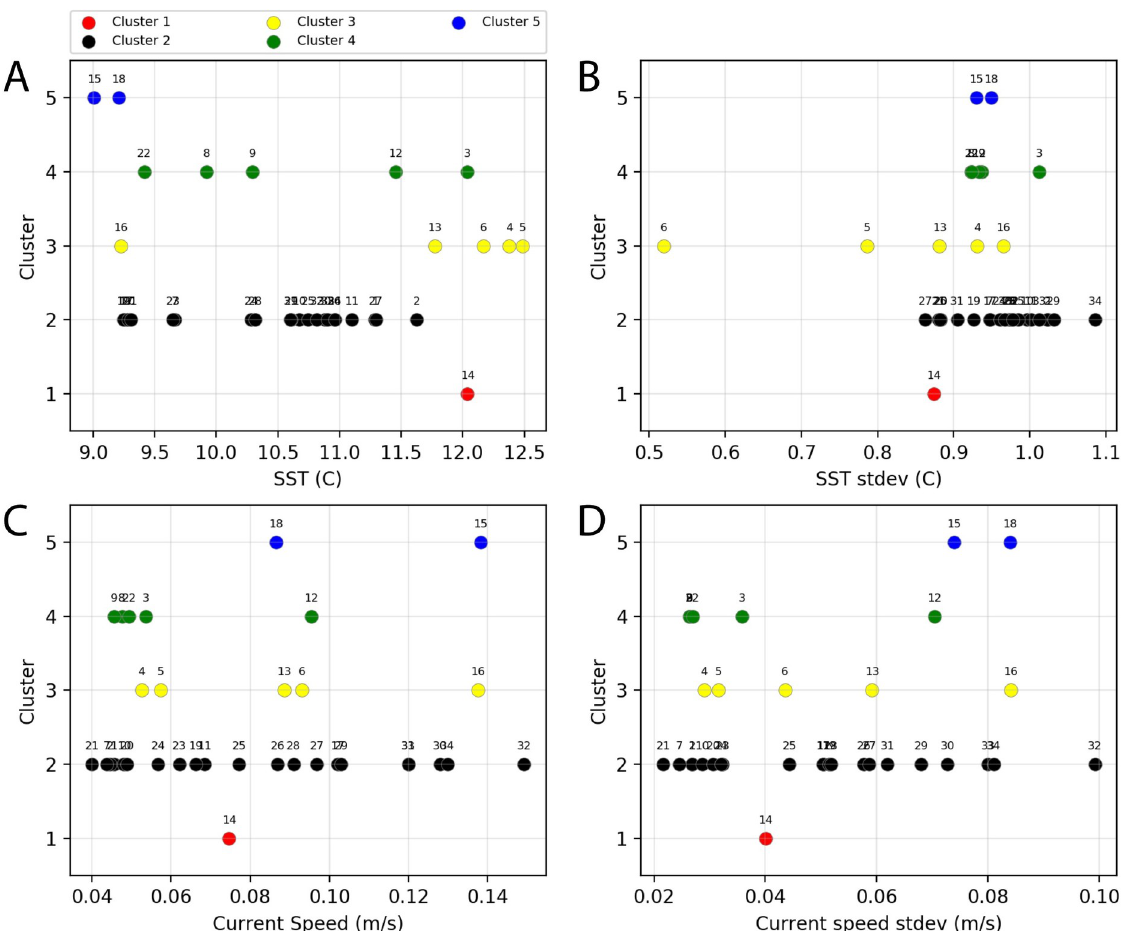
Fig 6. Relationship between community clusters and environmental variables. Distribution of (A) mean SST; (B) mean SST standard deviation; (C) mean current speed; (D) mean current speed standard deviation. All climatological means were produced for the period May 16-August 15, 2000–2016. The numbers near each data point refer to the Bin ID, as represented in Fig 4.